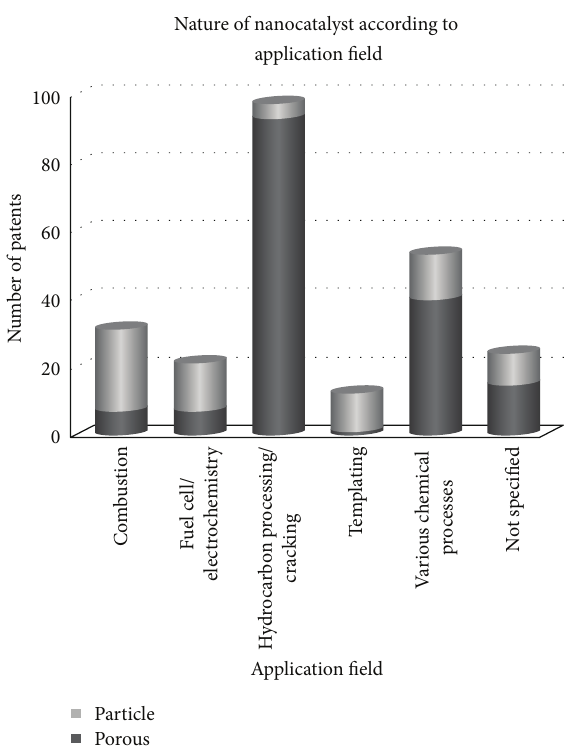
Figure 10: Proportion of nanoporous and nanoparticle catalysts used in the specified application fields (based on a research on the US Patent and Trademark Office Patent Database (http://patft .uspto.gov/) applying the working definition stated in the beginning of this review).